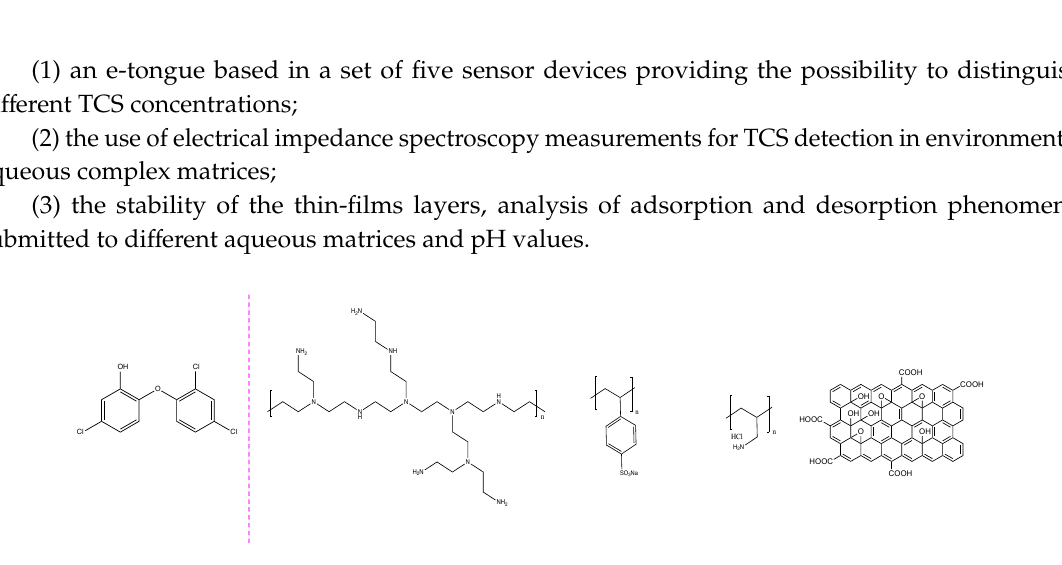
Table 1. Characterization of the environmental matrices under study.